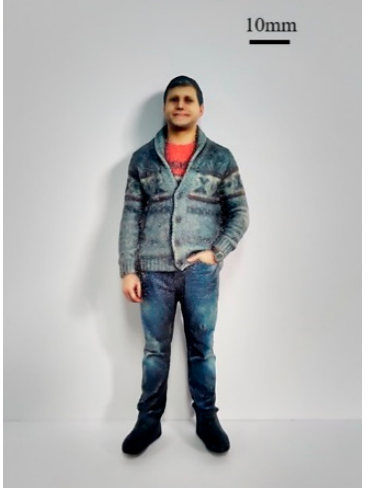
Figure 5. BJ printed full-color portrait.